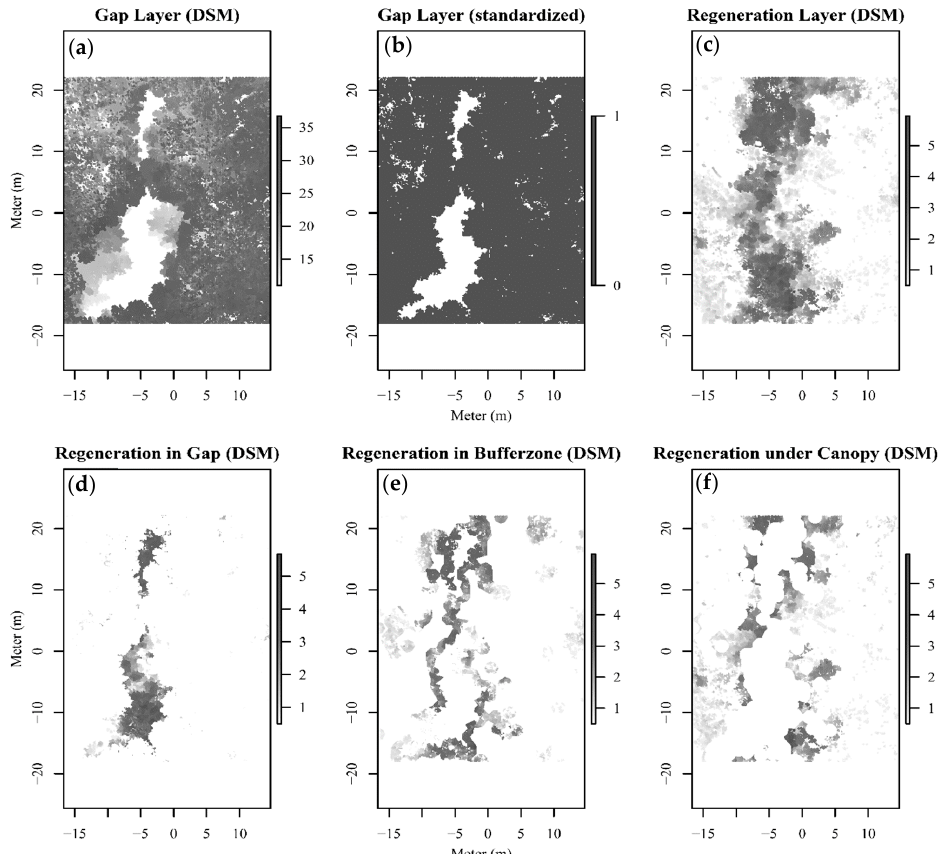
Figure 4. Exemplary maps of horizontal (xy)-cells based on the point cloud grid of a plot, here from one of the Hainich sites. Digital surface models of gap layer ( a ) and regeneration layer ( c ), standardized 0/1 canopy layer showing the gap ( b ). ( d – f ): Elements of the regeneration layer located in the gap ( d ), in a buffer zone of 1 m around regeneration in gap ( e ) (here exemplary buffer zone 0–1 m), and ( f ) remaining regeneration under densely closed canopy. DSM = digital surface model.